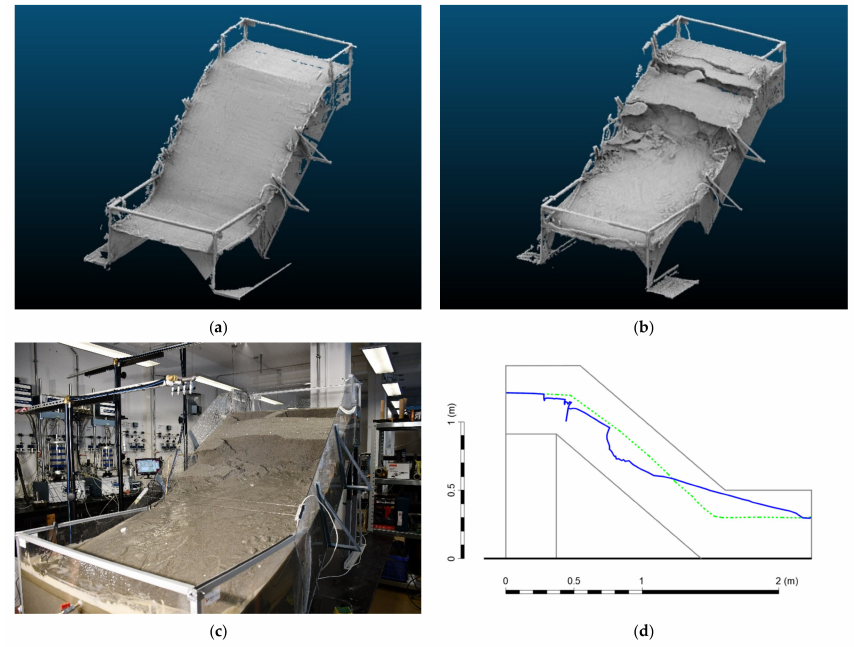
Figure 13. Results of terrestrial laser scanner (TLS) survey at slope inclination of 40 ◦ : ( a ) before the test starting; ( b ) at the end of the test; ( c ) photo of the physical model at the end of the test; ( d ) contour profiles of terrain before and after the sliding—green line initial stage, blue line final